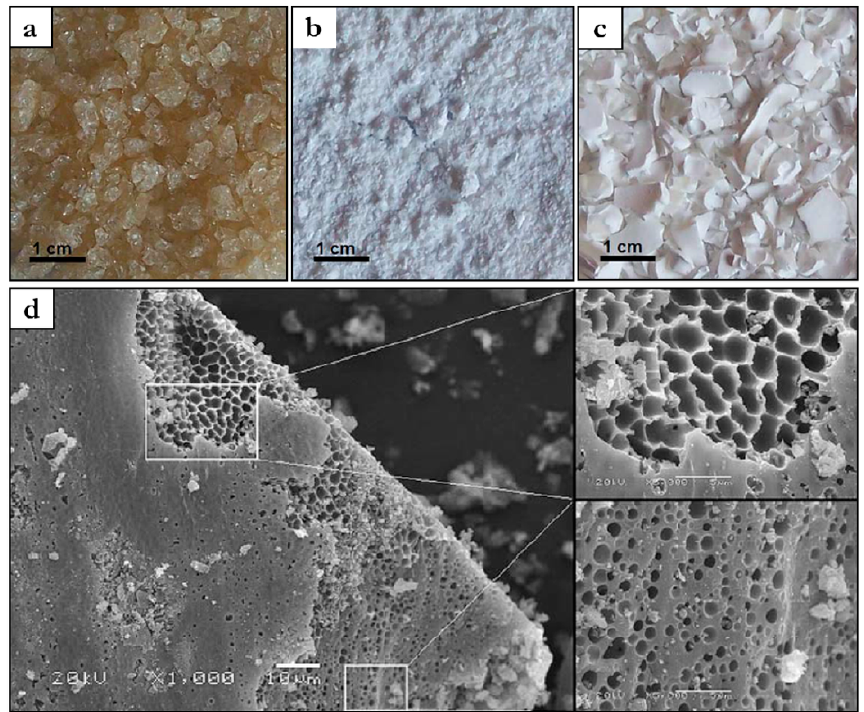
Figure 5. Photographs of silica xerogels synthesized with ( a ) [C 3 O 1 MIm][MeSO 3 ]); ( b ) [C 3 O 1 MIm][BF 4 ]) and ( c ) [C 3 O 1 MIm][PF 6 ]); before grinding and ( d ) SEM images of silica after [C 3 O 1 MIm][PF 6 ] extraction [60] (permission obtained for reproduction).